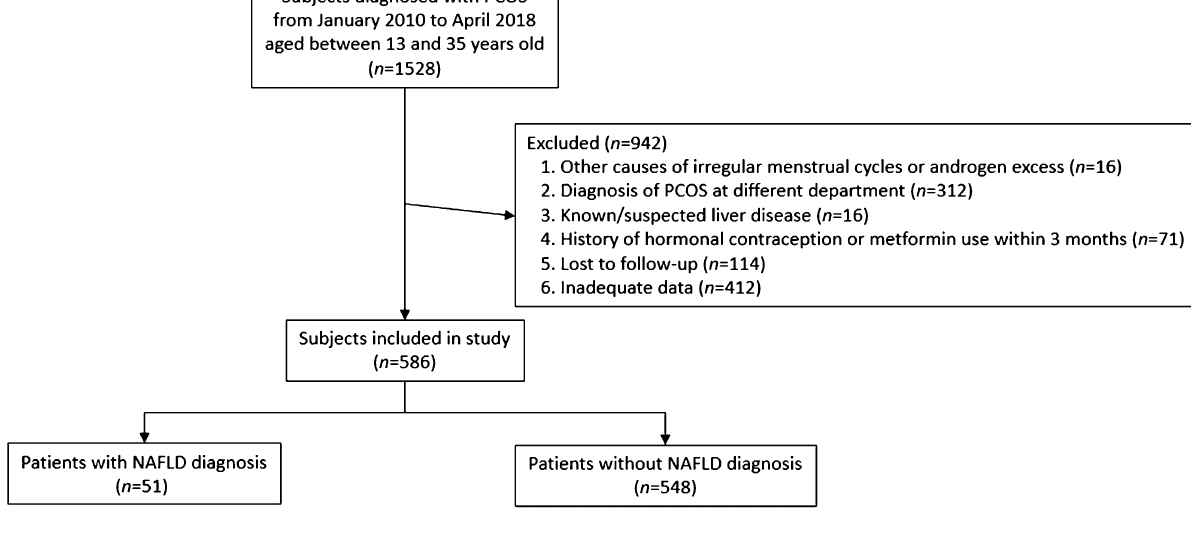
Figure 1. Flow chart of patient